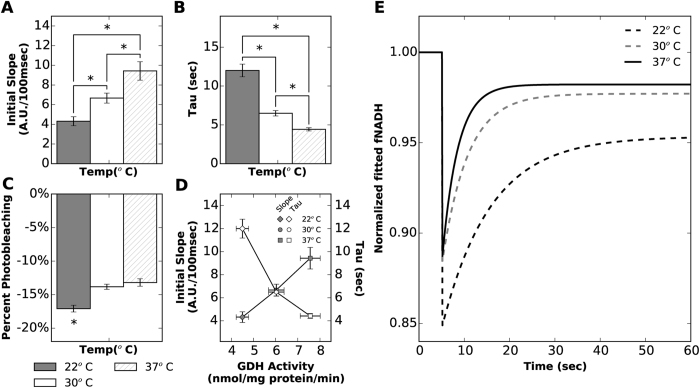
NADH ED-FRAP measurements (LP mode) for hearts perfused at three temperatures.Hearts were electromechanically uncoupled with BDM. (A) The initial slope of fNADH recovery increases with temperature (p < 0.001, n = 5). (B) The time constant of fNADH recovery (tau) drops with increasing temperature (p < 0.001, n = 5) (C) Percent photobleaching is greater at 22 °C (p < 0.001, n = 5) but not significantly different at 30 & 37 °C. (D) Initial slope and tau measured from hearts perfused at 22, 30, and 37 °C are plotted with GDH activity (n = 4) measured at the same temperatures. (E) Representative fNADH data acquired during NADH ED-FRAP were fitted (‘y’ in Equation 4) and plotted for the three temperatures studied.